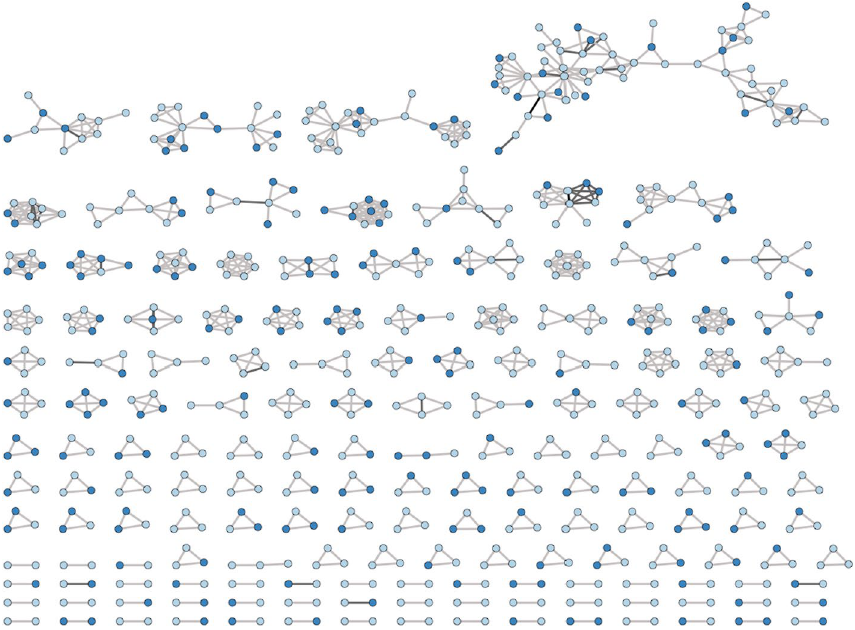
Fig. 3 Social network analysis journal’s co‑authorships. Source: Elaborated by the authors using the database of this